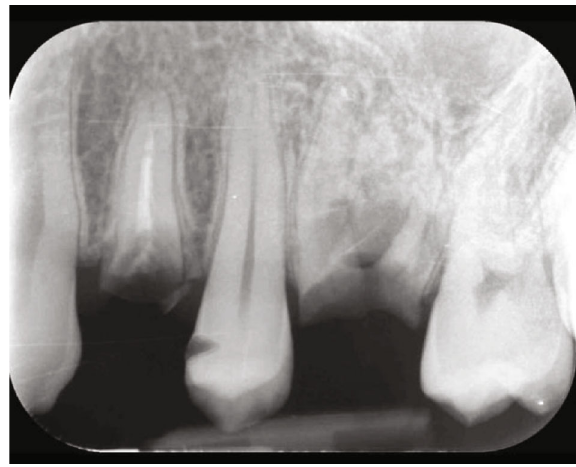
Figure 2: X-ray of the premolar with the presence of residual roots and the cavity on the crown.